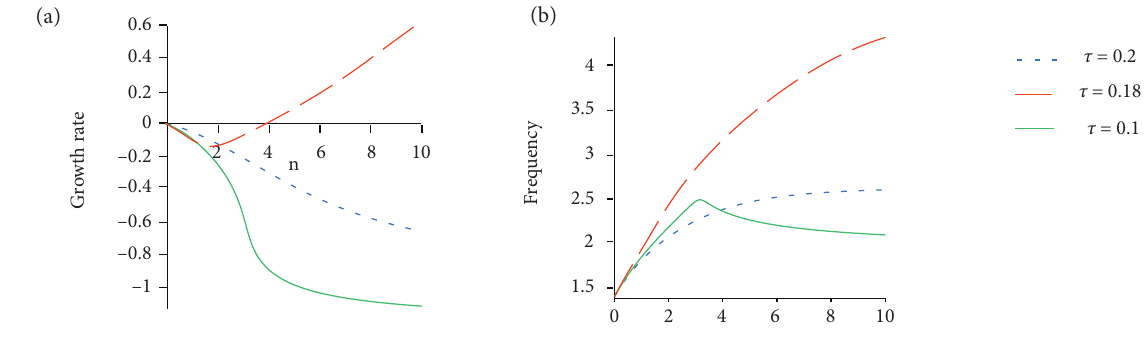
Figure 11. Thermoacoustic characteristics of a ducted resonator as combustion delay